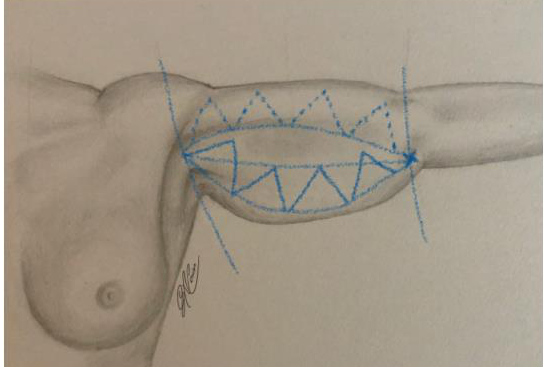
Figure 1. Preoperative